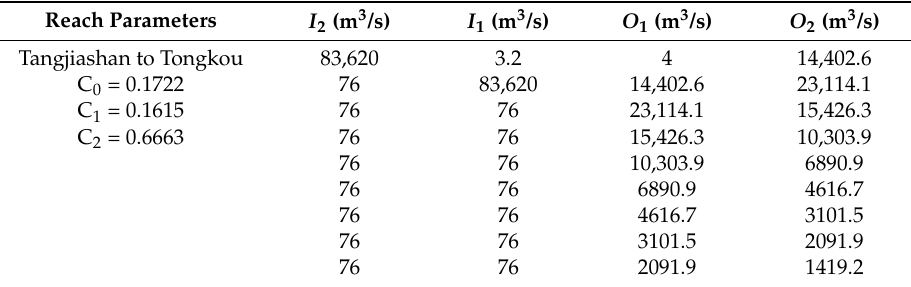
Table 6. Muskingum flood routing between Tangjiashan and Tongkou.